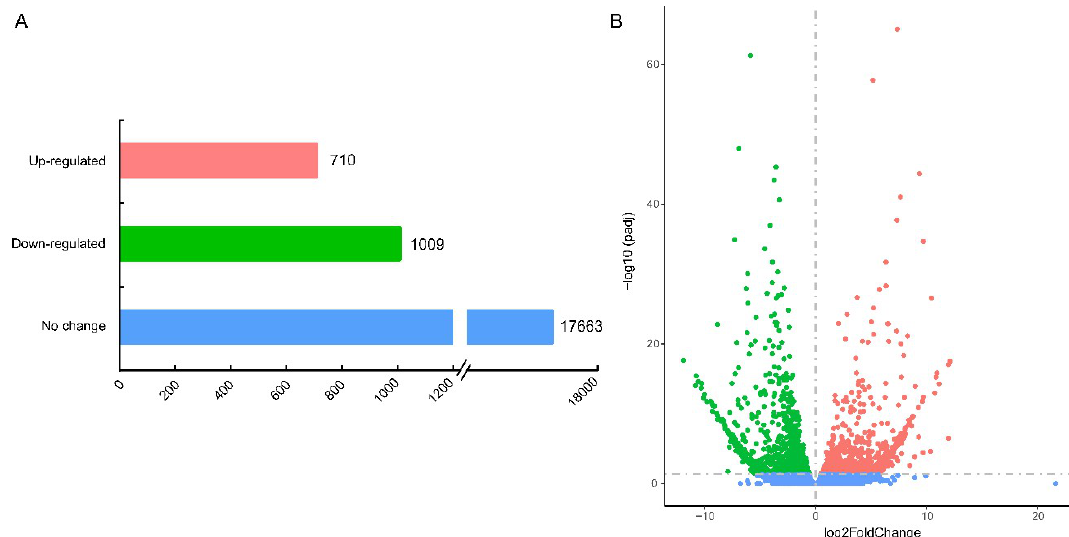
Figure 4. Expression levels between sk and wild-type Dazao. ( A ) The number of DEGs and non-regulated genes between sk compared to the wild-type Dazao. ( B ) Volcano plot of log2 fold-change against negative log10 of FDR value ( sk mutant versus wild-type Dazao). Red represents upregulated genes, green represents downregulated genes, and blue represents unaltered genes in the sk mutant compared to the wild-type Dazao under the criteria of FDR ≤ 0.05.